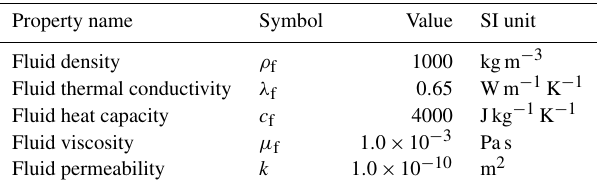
Table 1. Fluid properties for the example of heat transport in a frac-